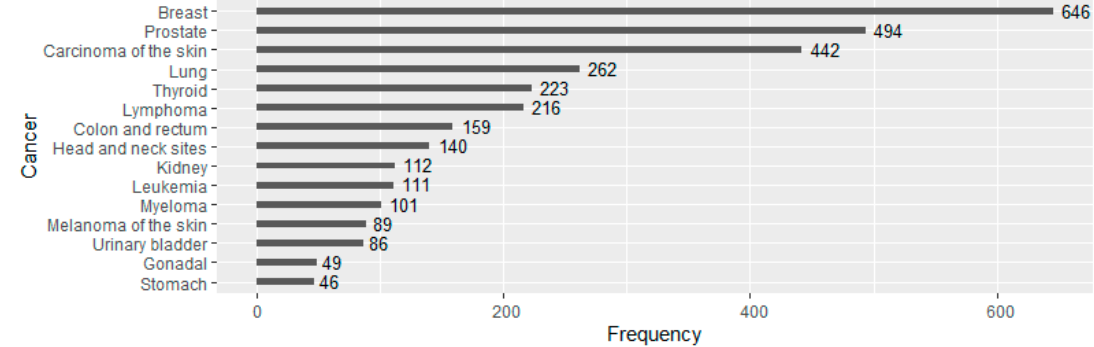
Figure 3. Top 15 cancer diagnoses in WTC EHC pan-cancer database. Table 2. Top 15 cancer diagnoses in males and females in WTC EHC pan-cancer database. Male